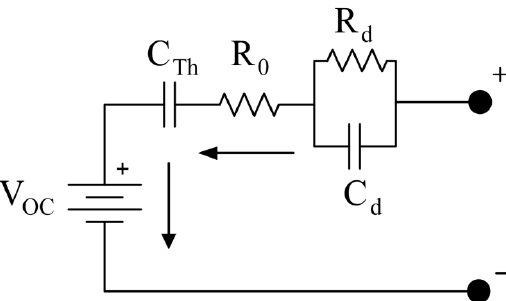
Figure 1. Equivalent circuit model (ECM) structure of an individual